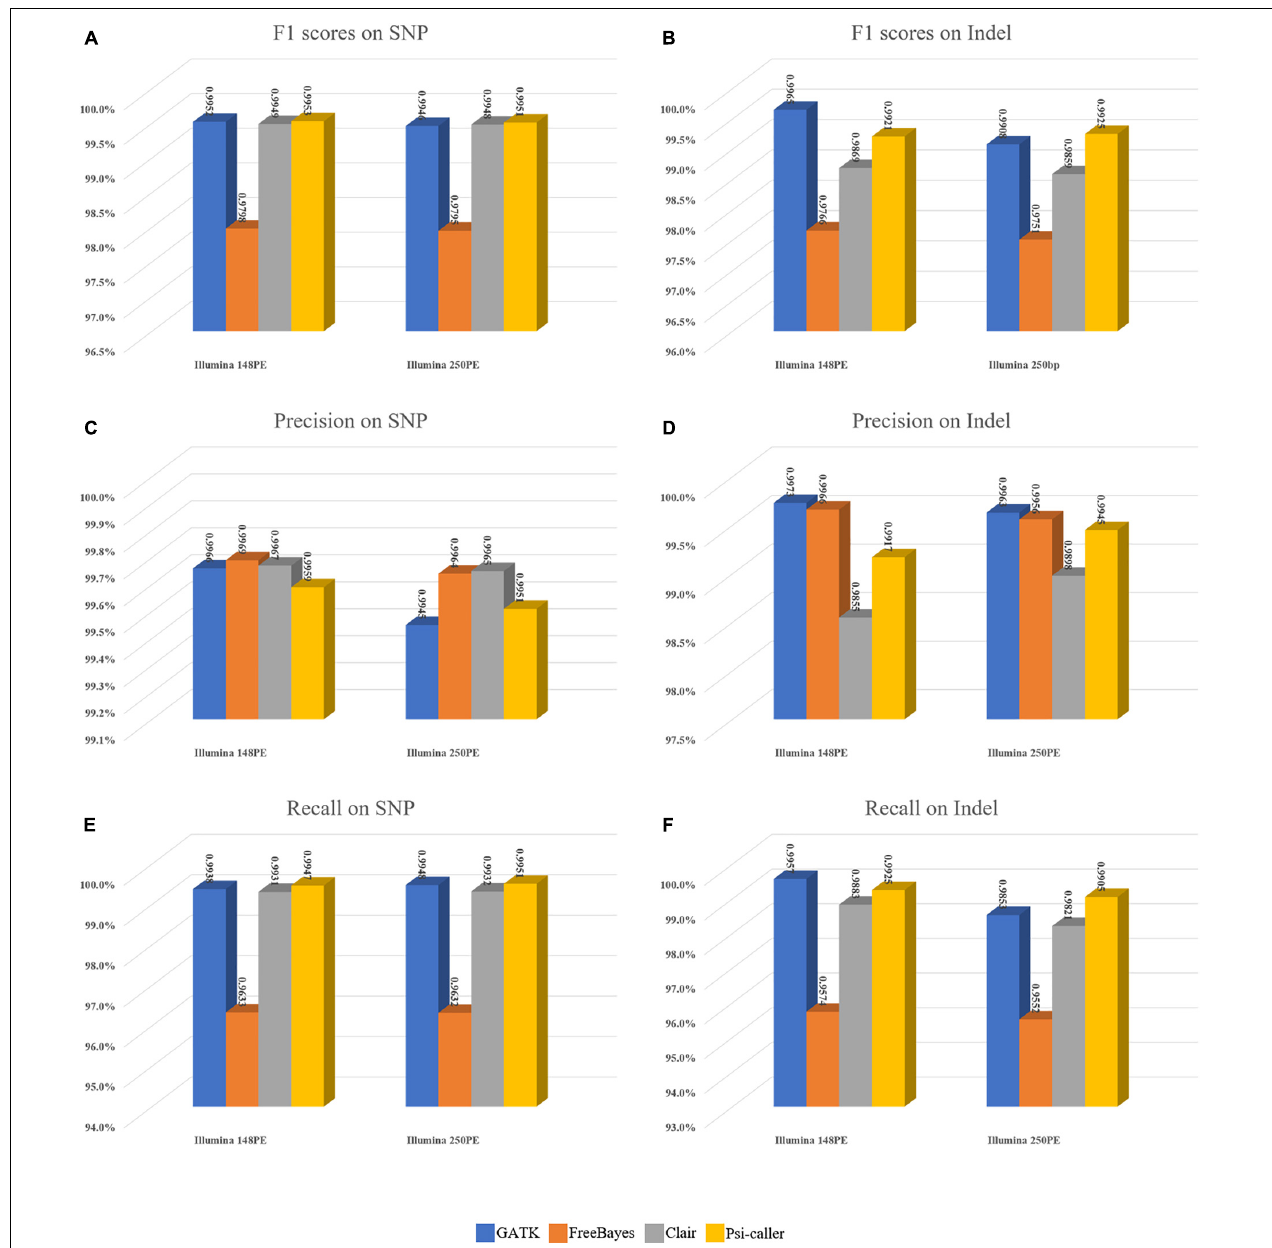
FIGURE 3 | Benchmark results of the variant callers on real sequencing data sets. (A,B) F1 scores on SNVs and Indels, respectively. (C,D) Precisions on SNVs and Indels, respectively. (E,F) Recalls on SNVs and Indels, respectively.